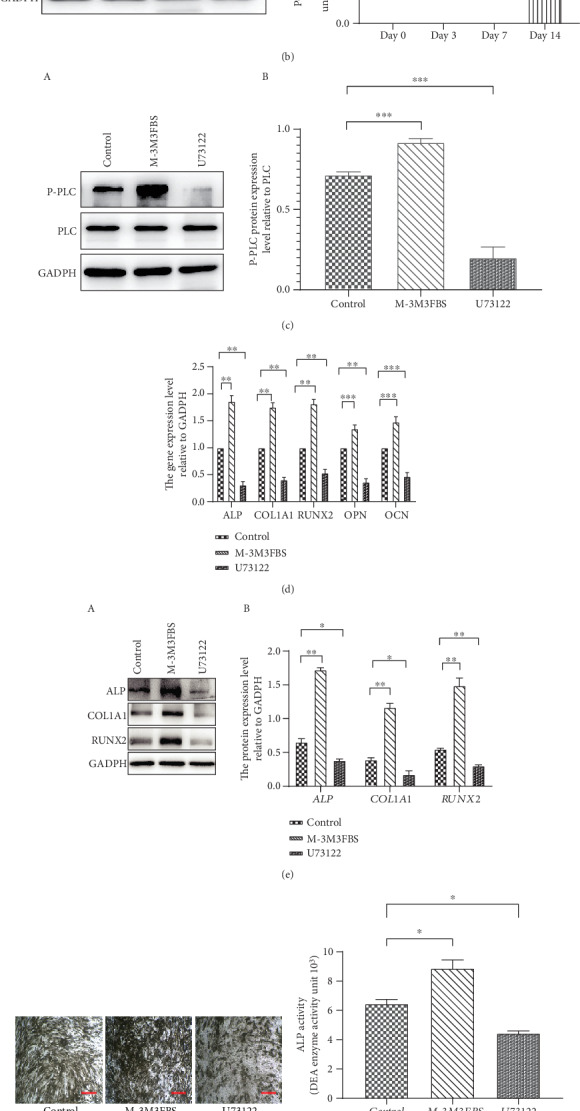
The effects of PLC (HSPG2) on the osteogenic differentiation of hBMSCs. (a) (A)The activity of PLC protein in cells induced with osteogenic medium for 0, 3, 7, and 14 days. (B) The relative activity of PLC protein was quantified and plotted. (b) (A) The expression of P-PLC protein in cells noninduced for 0, 3, 7, and 14 days. (B) Relative expression levels of P-PLC protein were quantified and plotted. (c) (A) Western blot analysis of PLC in cells induced with osteogenic medium or osteogenic medium supplemented with M-3M3FBS or U73122 induced for 14 days. (B) The relative activity of PLC protein was quantified and plotted. (d) RT-PCR analysis of osteogenic markers ALP, COL1A1, RUNX2, OPN, and OCN in cells induced with osteogenic medium or osteogenic medium supplemented with M-3M3FBS or U73122 induced for14 days. (e) (A) Western blot analysis of osteogenic marker proteins ALP, COL1A1, and RUNX2 in cells induced with osteogenic medium or osteogenic medium supplemented with M-3M3FBS or U73122 induced for 14 days. (B) The relative levels of osteogenic marker proteins were quantified and plotted. (f) Analysis of ALP staining in cells induced with osteogenic medium or osteogenic medium supplemented with M-3M3FBS or U73122 induced for 14 days. (g) Analysis of ALP activity (the unit for p-nitrophenyl: μmol) in cells induced with osteogenic medium or osteogenic medium supplemented with M-3M3FBS or U73122 induced for 14 days. (h) Analysis of ARS staining in cells induced with osteogenic medium or osteogenic medium supplemented with M-3M3FBS or U73122 induced for 14 days. (i) A quantification of ARS in cells induced with osteogenic medium or osteogenic medium supplemented with M-3M3FBS or U73122 induced for 14 days. Scale: 200 μm. ∗P < 0.05, ∗∗P < 0.01, and ∗∗∗P < 0.0001.